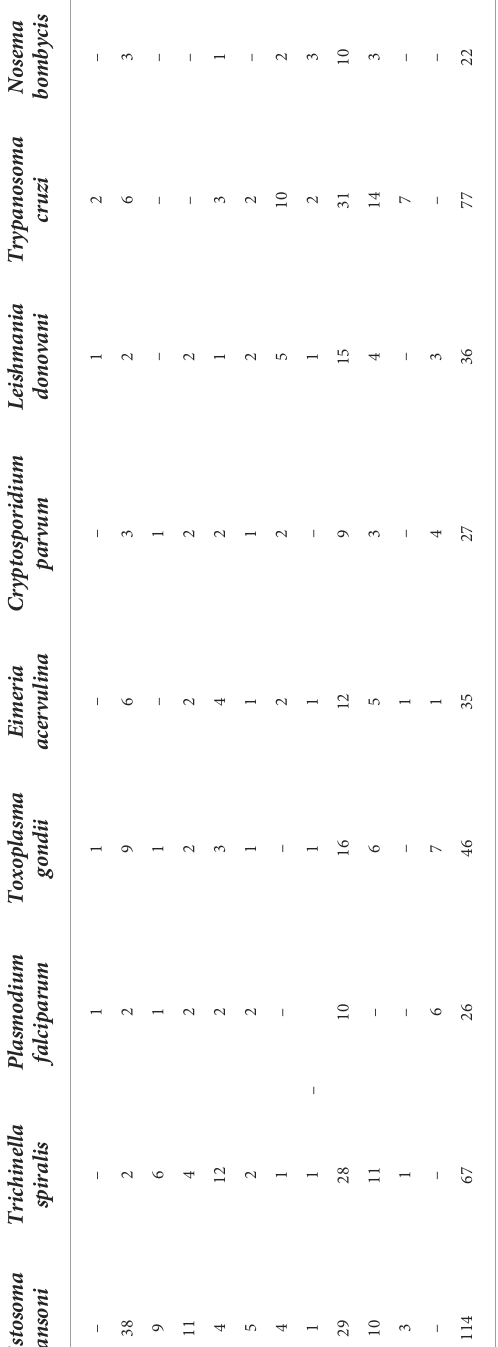
various classes were used as a query protein in a BLASTP search against the parasite databases provided in Table 3.